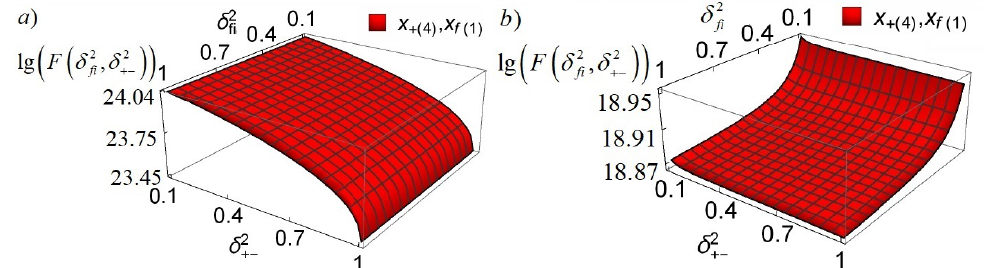
Figure 10. ( a ) The angular distribution of the resonant differential probability per unit time of the process (see Expression (52)) for positrons with the energies x +( 4 ) for x f ( 1 ) . The energy of the field quanta ω = 1 keV, the energy of the initial electron E i = 100 GeV, the initial electron propagates towards the X-ray wave. ( b ) The angular distribution of the resonant differential probability per unit time of the process (see Expression (52)) for high-energy positrons x +( 1 ) for x f ( 1 ) with the energies similar to the initial electron energy. The energy of the field quanta ω = 1 keV , the energy of the initial electron E i = 100 GeV, the initial electron propagates towards the X-ray